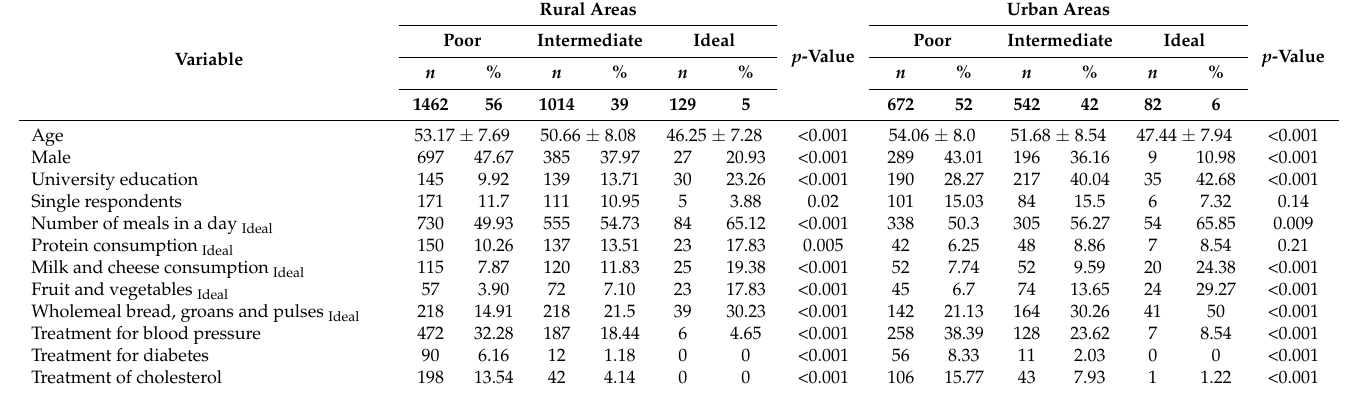
Table 2. Characteristics of the group according to their cardiovascular health.